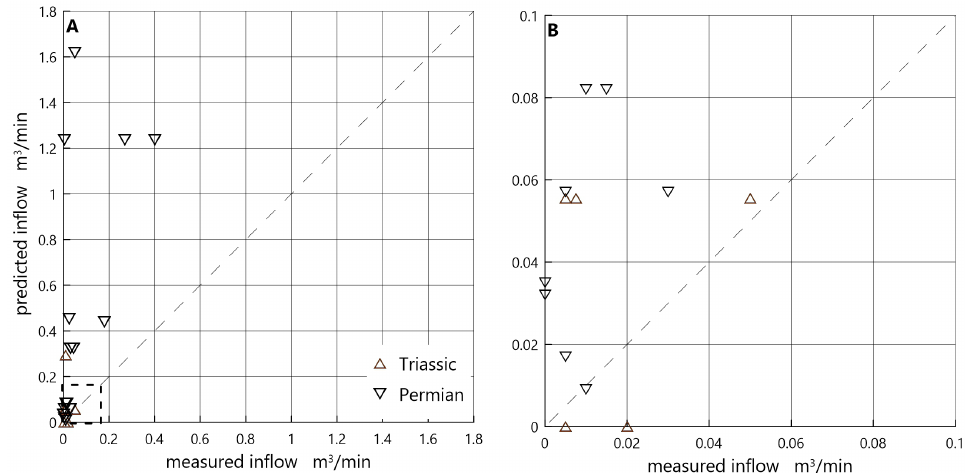
Figure 1. Comparison of predicted and measured inflows into the sinking shaft R-XI; ( A ) complete data, ( B ) data in the range up to 0.1 m 3 /min (black square in ( A ); [2]